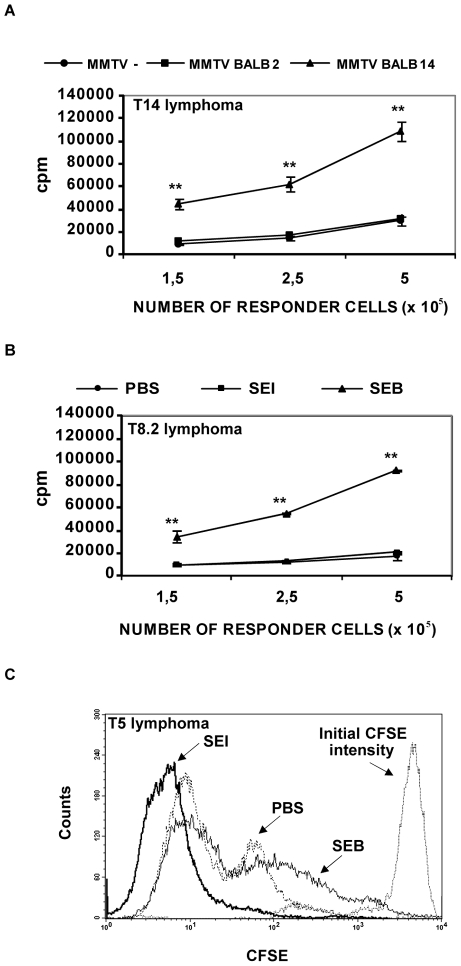
Sags induce increases in the proliferative levels of cognate lymphoma T cells.(A–B) Proliferative response of lymphoma T cells in vitro. (A) Different numbers of T14 lymphoma cells were co-cultured with 0.7×105 mitomycin C-pretreated splenocytes from (•) non-infected AKR/J mice, (▪) MMTV BALB2-infected AKR/J mice or (▴) MMTV BALB14-infected AKR/J mice. The proliferative response was assessed by 3H-thymidine incorporation during the last 18 hr of a 1-day culture period. Data are expressed as the mean ± SD, n = 5, **p<0.01. (B) Different numbers of T8.2 lymphoma cells were co-cultured with 0.7×105 mitomycin C-pretreated intraperitoneal macrophages in the presence of 10 µg/ml of (▪) SEI, (▴) SEB or (•) PBS. The proliferative response was assessed by 3H-thymidine incorporation during the last 18 hr of a 1-day culture period. Data are expressed as the mean ± SD, n = 5, **p<0.01. (C) Proliferative response of lymphoma T cells in vivo. CFSE-stained T5 lymphoma cells (5×106) were transferred intraperitoneally into syngeneic AKR/J mice. The mice were divided into three groups (n = 3 per group) and received an intraperitoneal injection of 25 µg of SEB, SEI or PBS. Twenty four hours later cells were collected by intraperitoneal washing and CFSE fluorescence was analyzed. Overlayed histograms depict a representative example. All the experiments were performed three times with similar results.